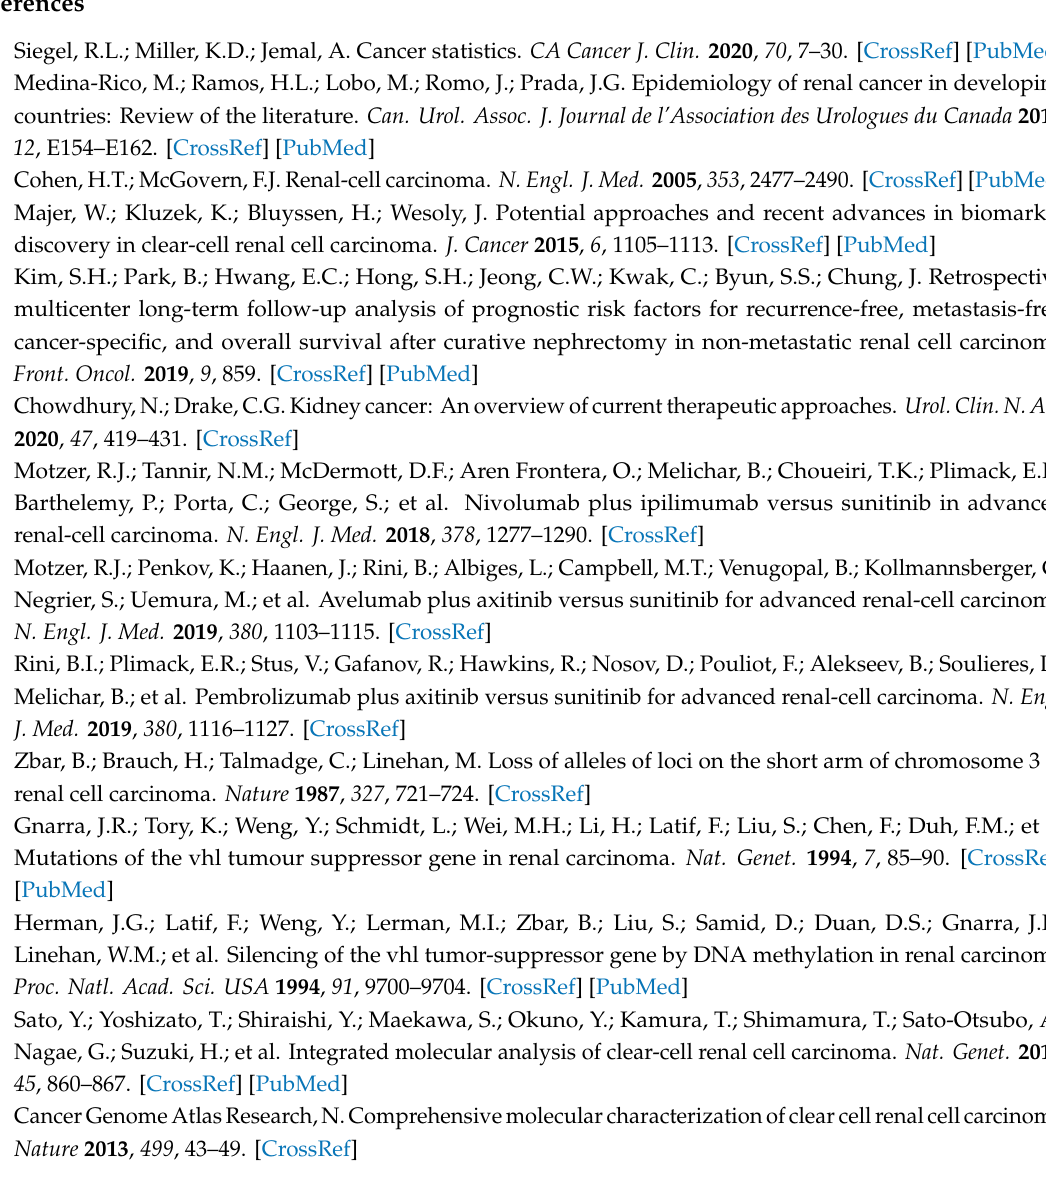
Figure S1: Downregulation of IQGAP1 expression is associated with reductions in OS in ccRCC, Figure S2: Cuto ff point estimations for SigIQGAP1NW with respect to OS, DSS, and PFS; Figure S3: Kaplan Meier survival curves for individual component genes of SigIQGAP1NW; Table S1: DEGs relative to IQGAP1 downregulation; Table S2: Demographics of training and testing